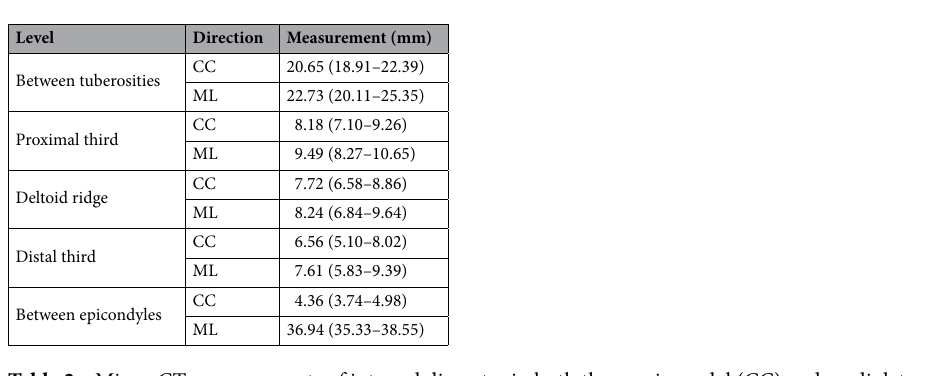
being between tuberosities.